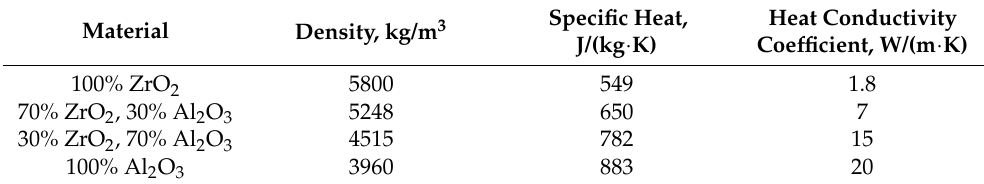
Table 1. Material parameters at ambient temperature.